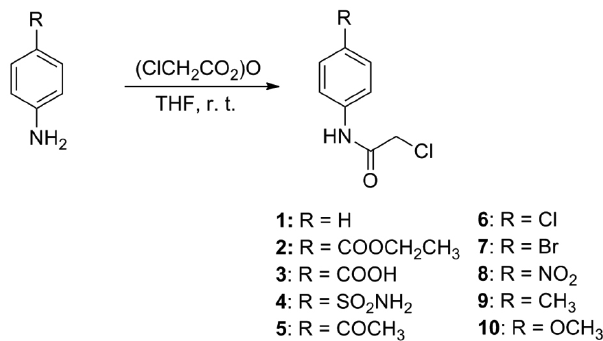
FIGURE 1 - Synthesis of 2-chloro- N -arylacetamide derivatives 1-10